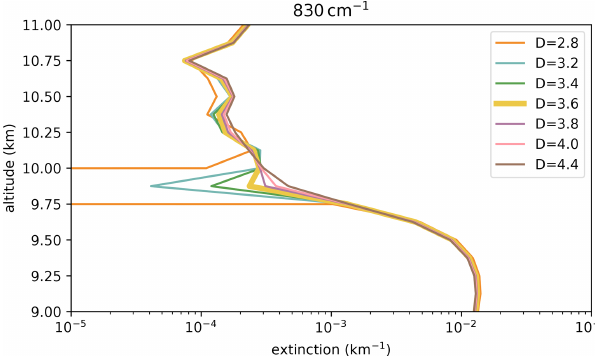
Figure 22. Examples of extinction profiles derived using point spread functions with differing